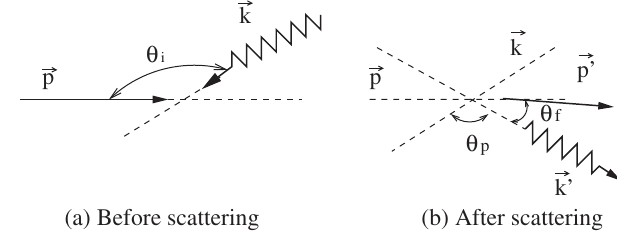
FIG. 1. Diagram of Compton scattering process. The vectors ~p and ~k represent the momenta of the electron and photon before the scattering, respectively. The vectors ~p 0 and ~k 0 represent the momenta of the electron and photon after the scattering, respec- is the angle between ~p and ~k , (cid:3) the angle between ~k tively. (cid:3) i p and ~k 0 , and (cid:3) the angle between ~p and ~k 0 f